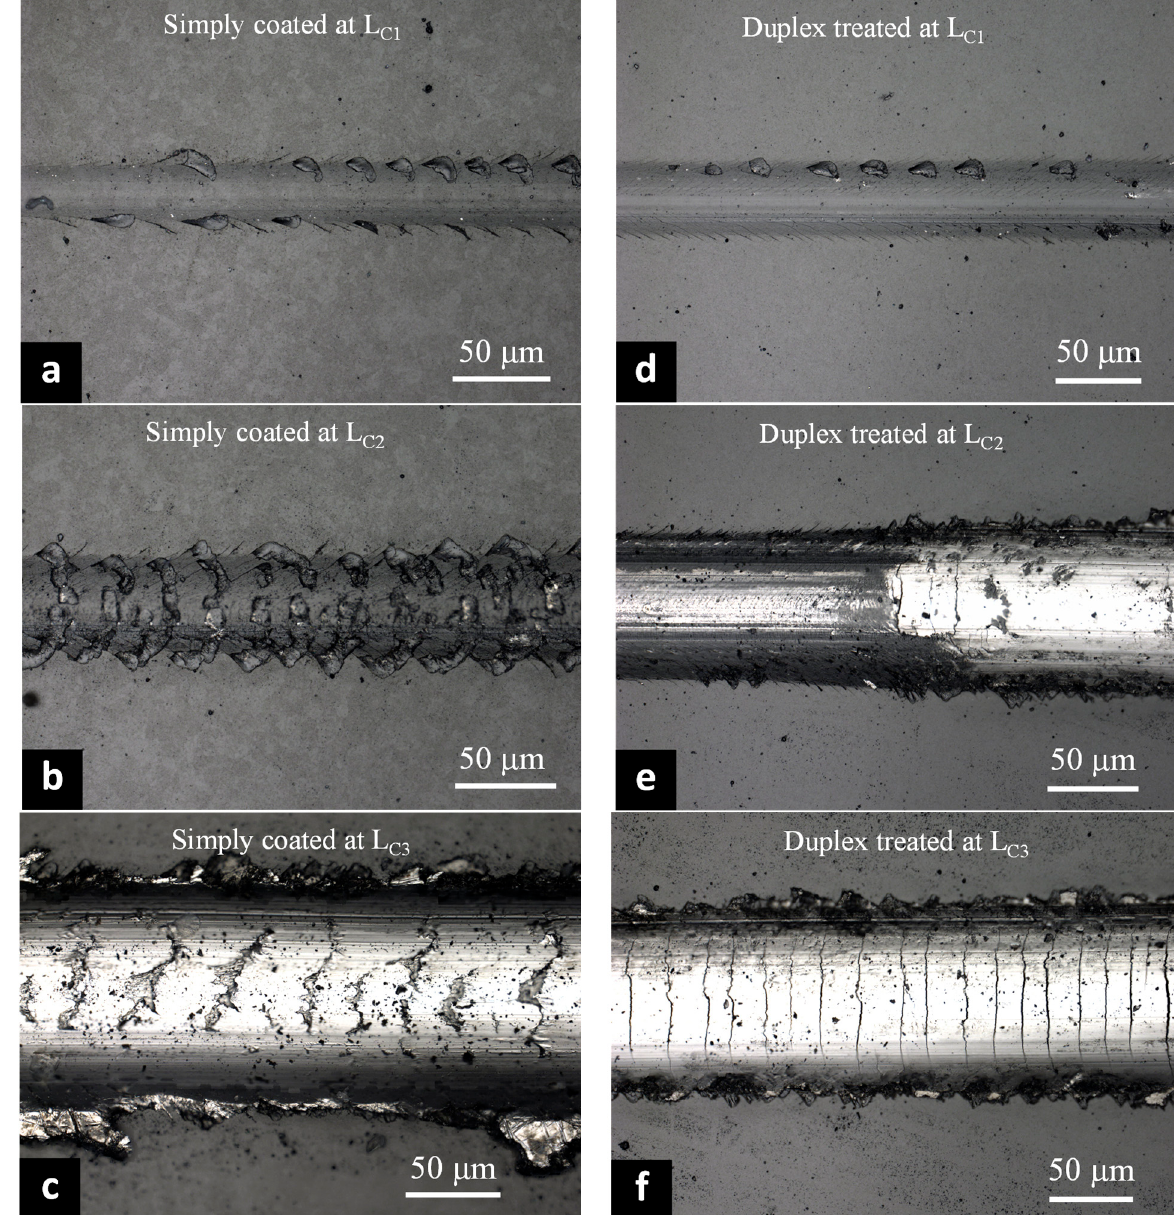
Figure 5. Optical micrographs illustrating the characteristic damage mechanisms that occurred at the subcritical and critical loadings in the simple DLC coated system ( a – c ) and the duplex-coated DLC system ( d – f